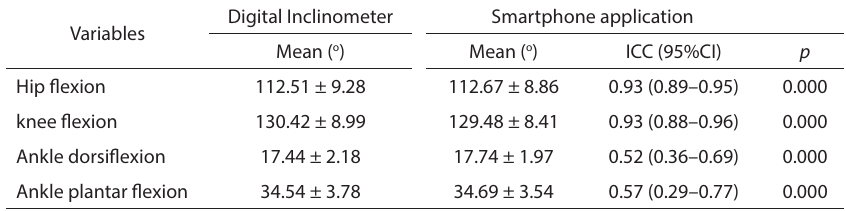
Table 1. Validity of the Digital inclinometer and Smartphone application for active hip, knee and ankle ROM. Mean data presented as mean ± standard deviation